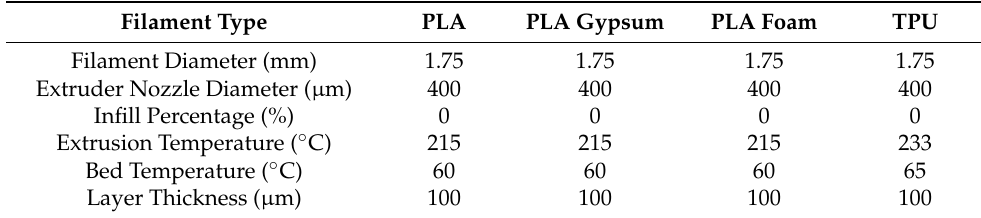
Table 3. Printing characteristics of the